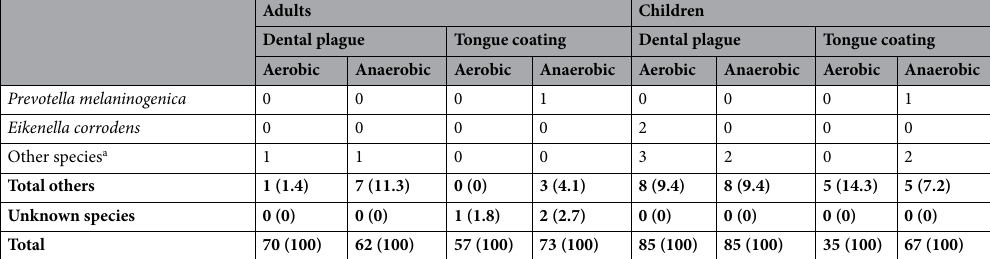
Table 1. The number and proportion of NO 2− -producing bacteria identified in the dental plaque and tongue coating samples from adults and children. Bold values indicate the total number for each bacterial genus. *The value in parentheses is percentage in total. a Only once detected bacteria, including Aggregatibacter segnis, Staphylococcus epidermidis, Moraxella lacunata, Leptotrichia hofstadii, Gemella morbillorum, Campylobacter concisus, Lachnoanaerobaculum umeaense , and Morococcus